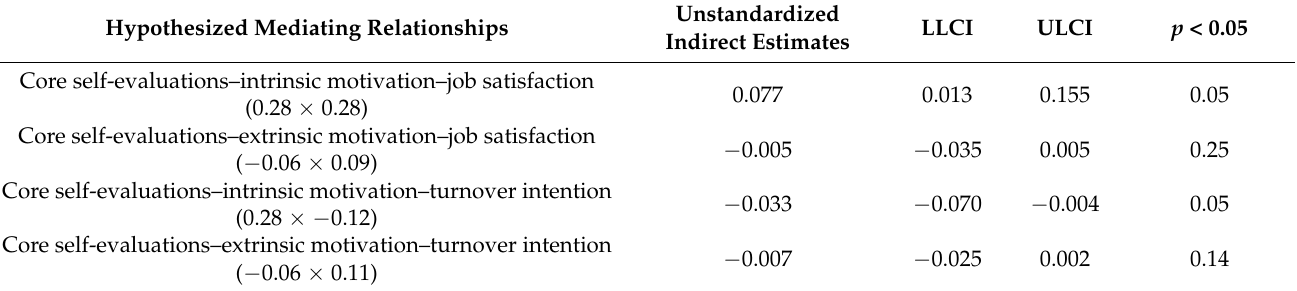
Table 4. Bootstrapping findings of the mediating effects of intrinsic and extrinsic